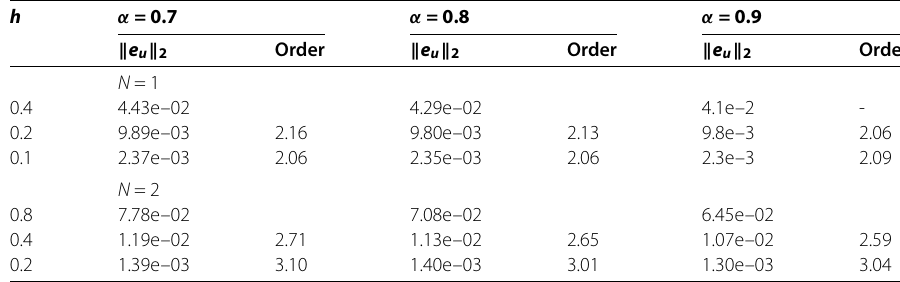
Table 2 Error and order of convergence of spatial discretization for example 1